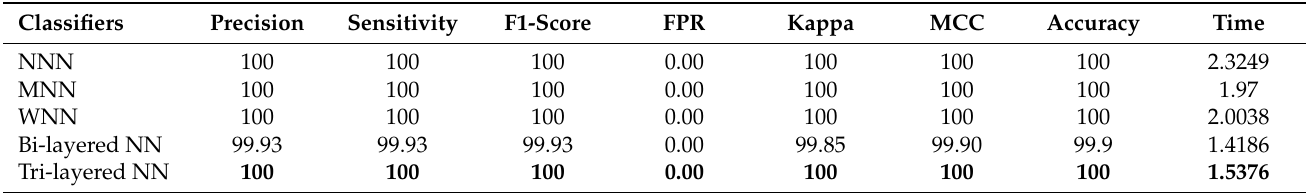
Table 13. Proposed approach comparison with latest techniques.